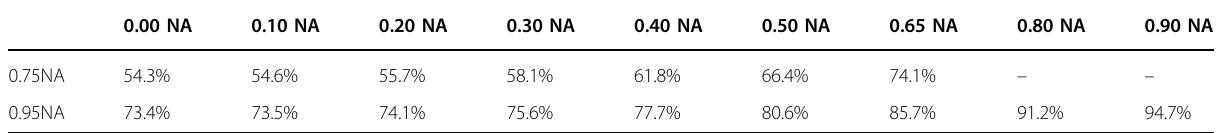
Table 2 Longitudinal-to-total fi eld ratio, generated by radial polarisation beam focused by the 0.75 NA lens and the 0.95 NA lens with different inner NAs